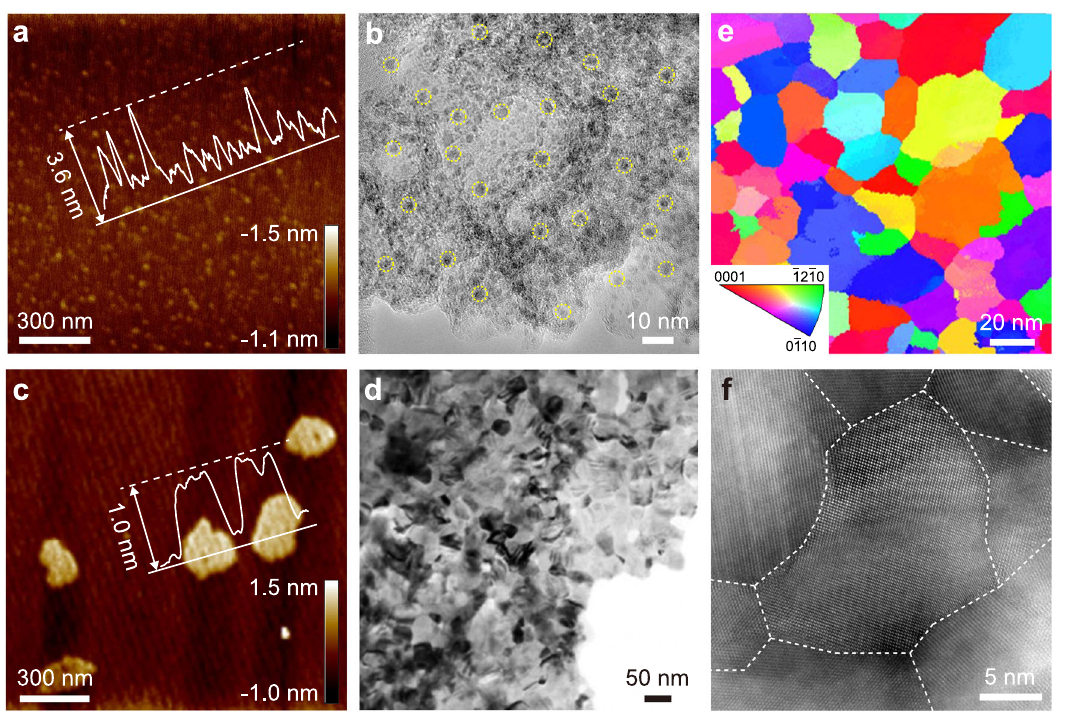
Fig. 2 | Structural characterizationofMo 2 C hybrids.a , c AFM images of a Mo 2 C/ NG and c H-Mo 2 C/NG and their corresponding height pro fi les. b , d TEM images of b Mo 2 C/NG and d H-Mo 2 C/NG. Mo 2 C NPs are highlighted by yellow dotted circles.